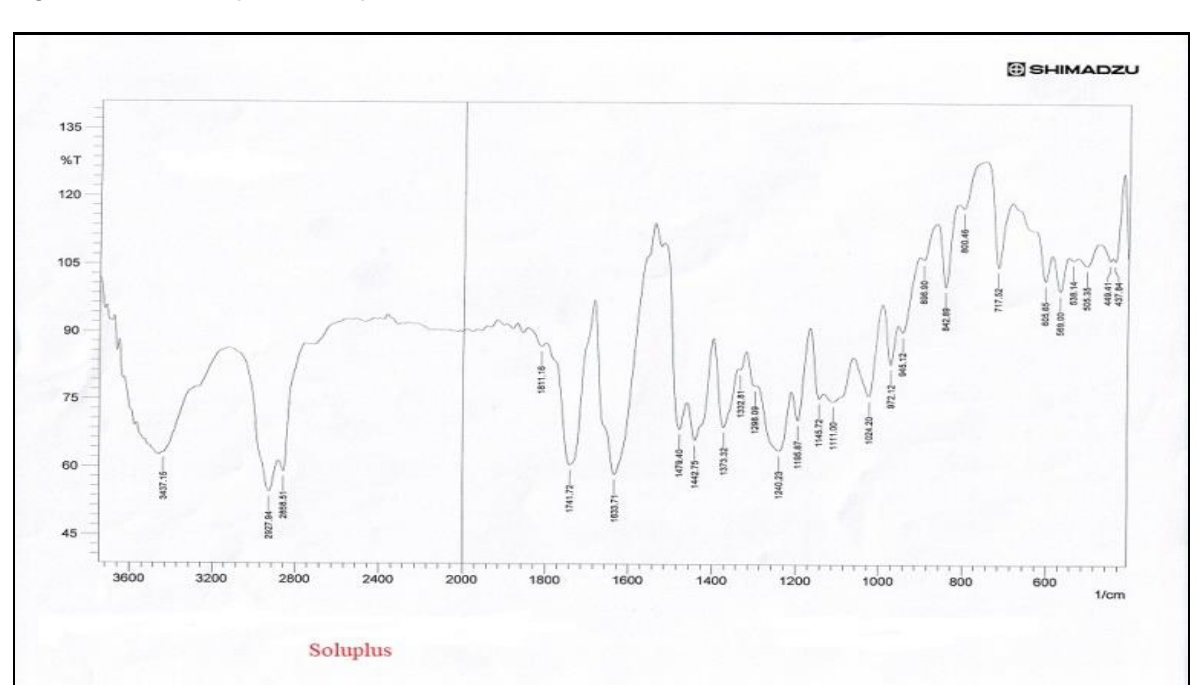
Figure 8. The FTIR spectrum of pure NMD